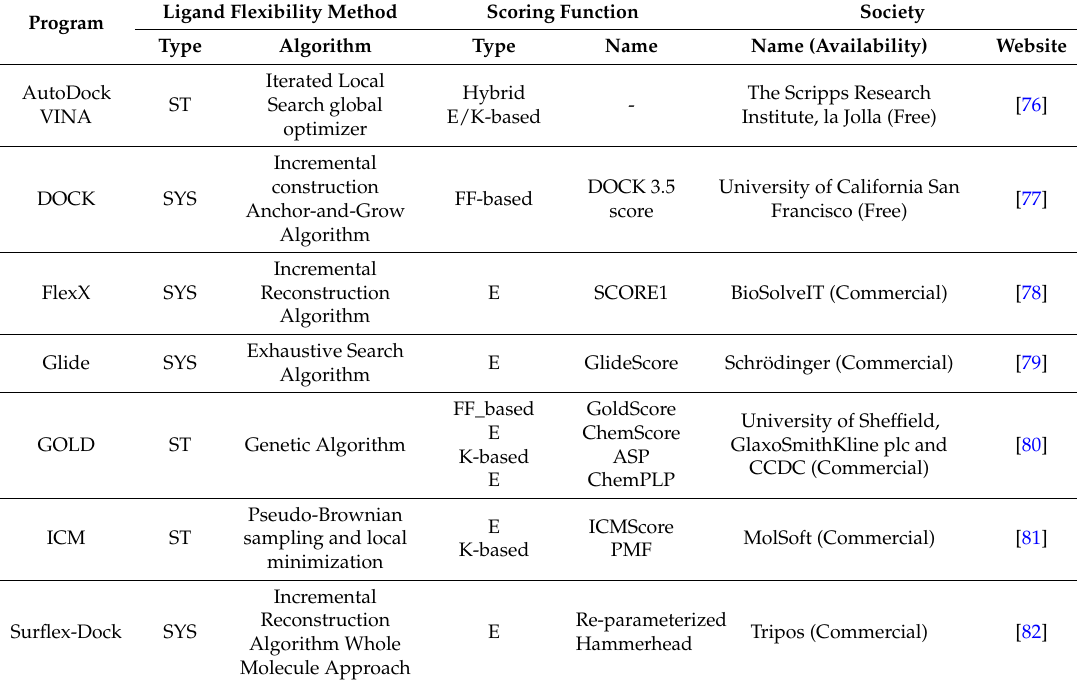
Table 1. Overview of the docking programs employed for virtual screening (VS) in Toll-like receptors (TLRs) mentioned in this review. ST: Stochastic; SYS: Systematic; E: Empirical; FF-based: Force field based; K-based: